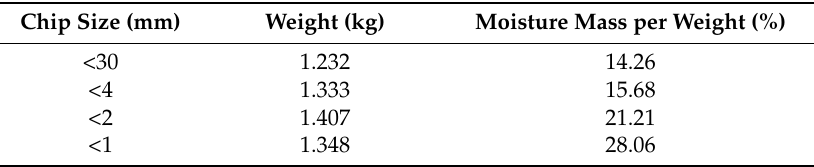
Table 2. Biomass chips characteristics.